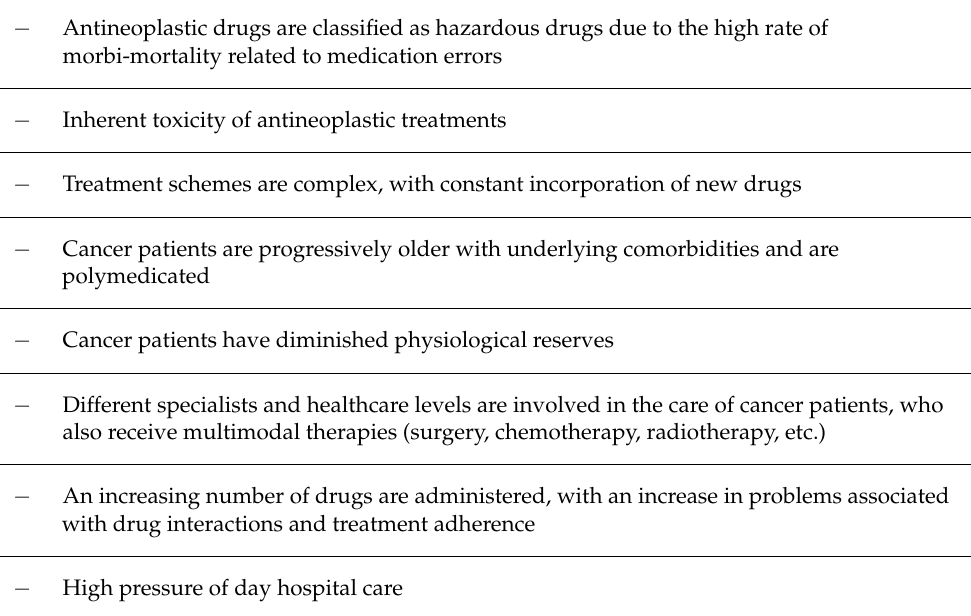
Table 2. Factors associated with safety concerns in cancer